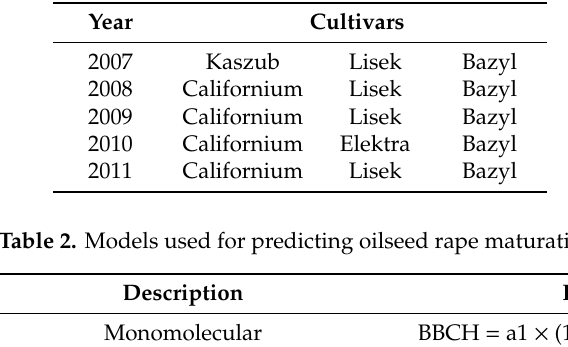
Table 1. Cultivars used in the experiments aimed at model development.